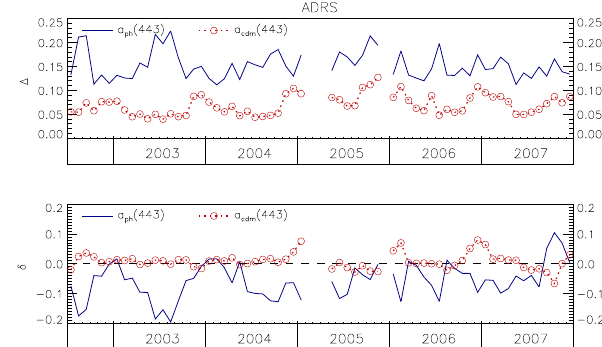
Fig. 6. Monthly time series of 1 (upper panel) and δ (lower panel) obtained from the comparison conducted with a (412), a (443), a A (488) versus a S (490), and b bp (555).